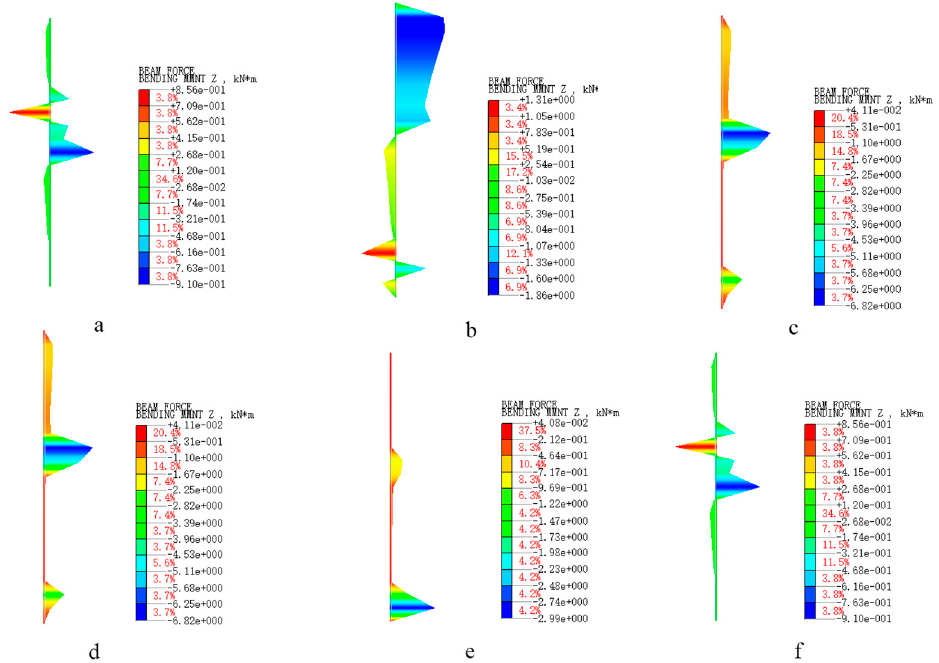
Figure 11. Tap root bending moment diagram of the first to sixth rows: ( a ) The first row, ( b ) The second row, ( c ) The third row, ( d ) The fourth row, ( e ) The fifth row, ( f ) The sixth row.